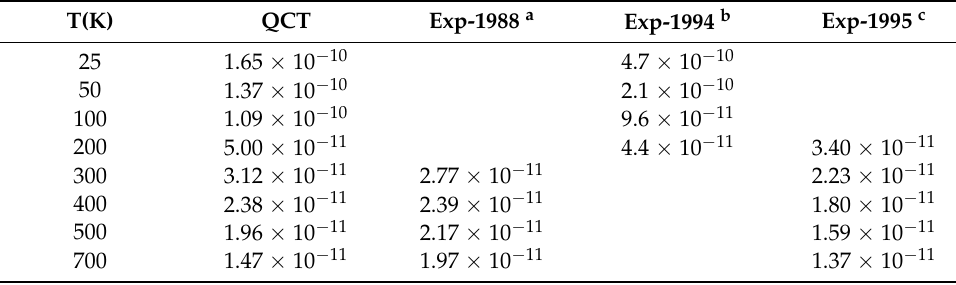
Table 3. Rate constants (cm 3 molecule − 1 s − 1 ) for the CN + NH 3